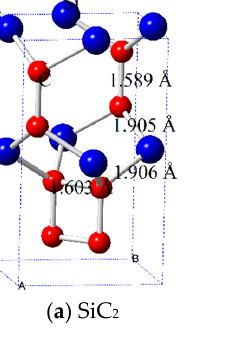
Figure 1. Unit cell crystal structures of SiC 2 ( a ) and SiC 4 ( b ).